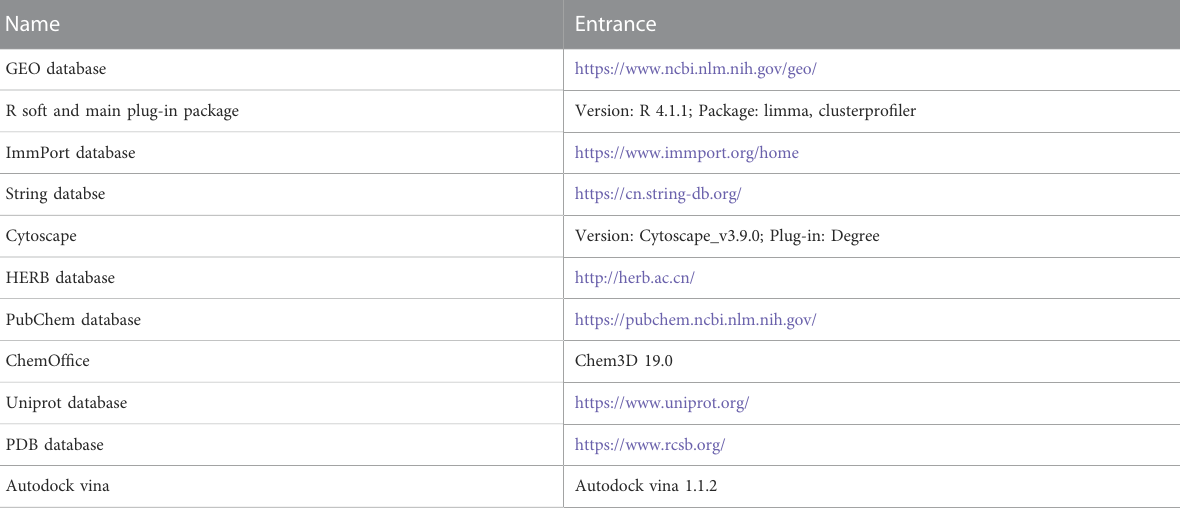
TABLE 1 All relevant software and websites used in this study.